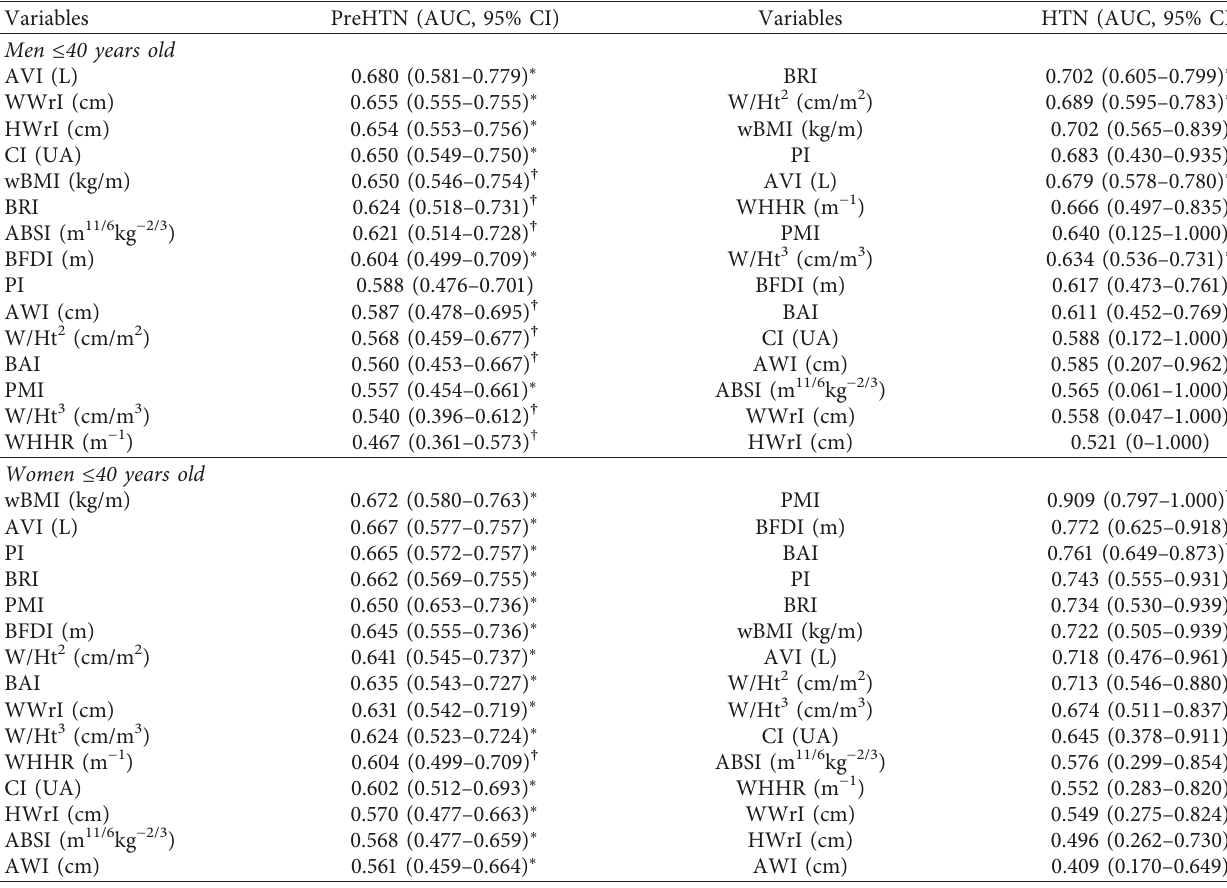
Table 4: Predictive value of the emergent anthropometric indices for preHTN and HTN by gender in ≤ 40 years old.